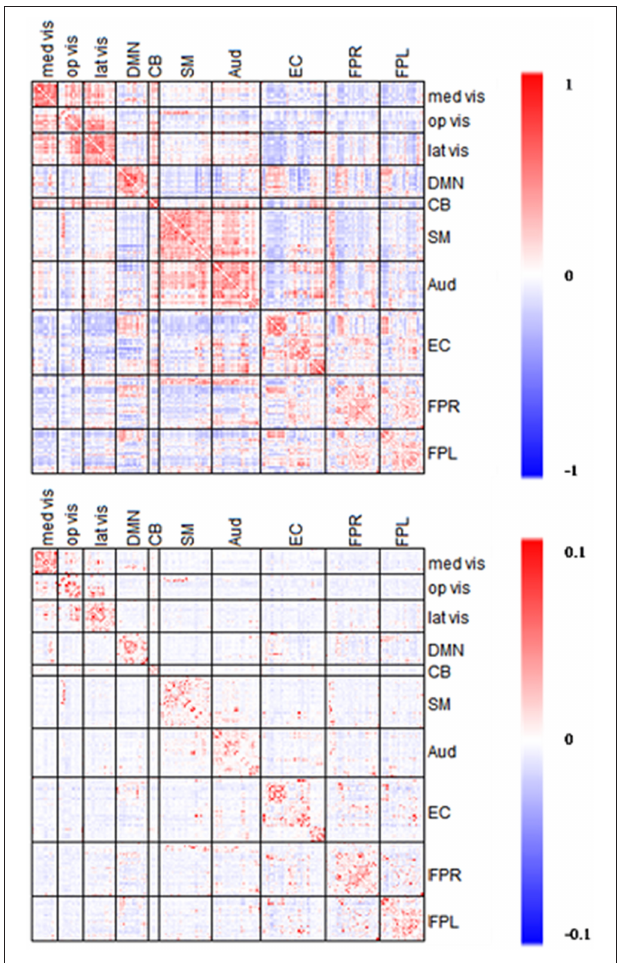
FIGURE 7 | Averaged edgewise partial correlation matrix ( λ * platu ) and full correlation matrix. The symmetric 232 232 connectivity matrices under × partial correlation ( λ * platu , bottom ) and full correlation (Pearson correlation, top ). Red indicates the positive edges and blue indicates the negative